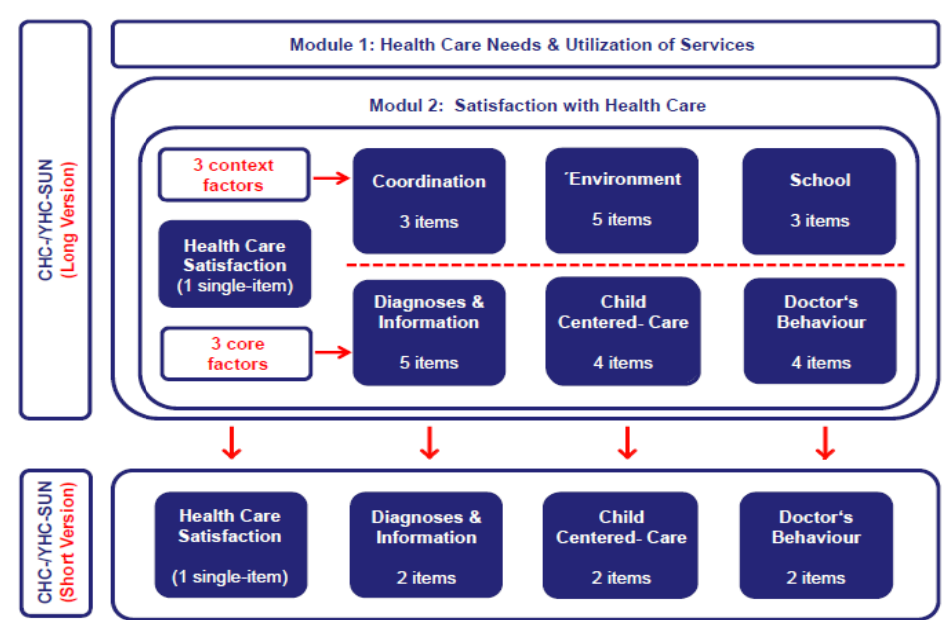
Figure 1. Overview of versions and content of different CHC-/YHC-SUN instruments for the assessment of special health care needs, health care utilization, and satisfaction with health care in children and adolescents with chronic health conditions.